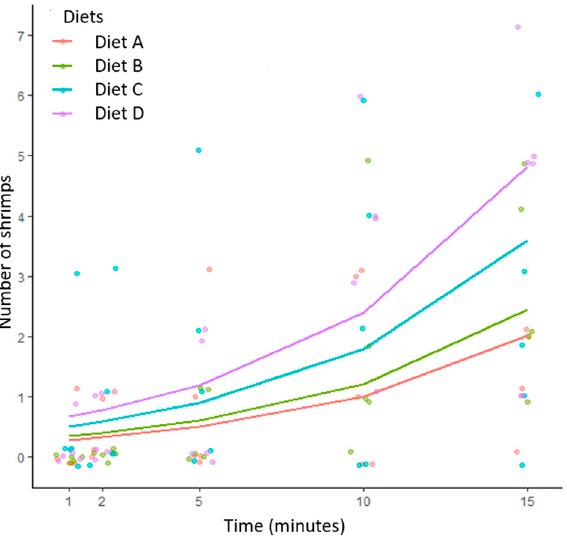
Figure 2. Jittered count observations at each time interval with the predicted performance fit for all four diets over time. Diet A: containing no palatability enhancers (control); diet B: containing squid meal and krill oil; diet C: containing 1% insect protein hydrolysate; diet D: contain 2% insect protein hydrolysate.